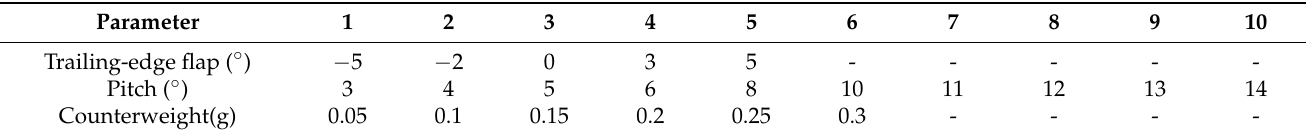
Table 2. Rotor adjustment parameters in this experiment.